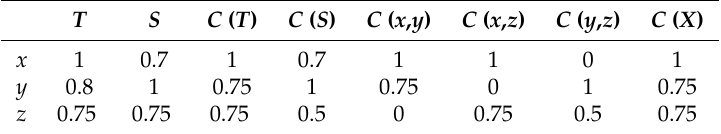
Table 5. The choice function and feasible subsets in Example 5. We omit brackets for simplicity. T S C ( T ) C ( S ) C ( x , y ) C ( x , z ) C ( y , z ) C ( X ) x